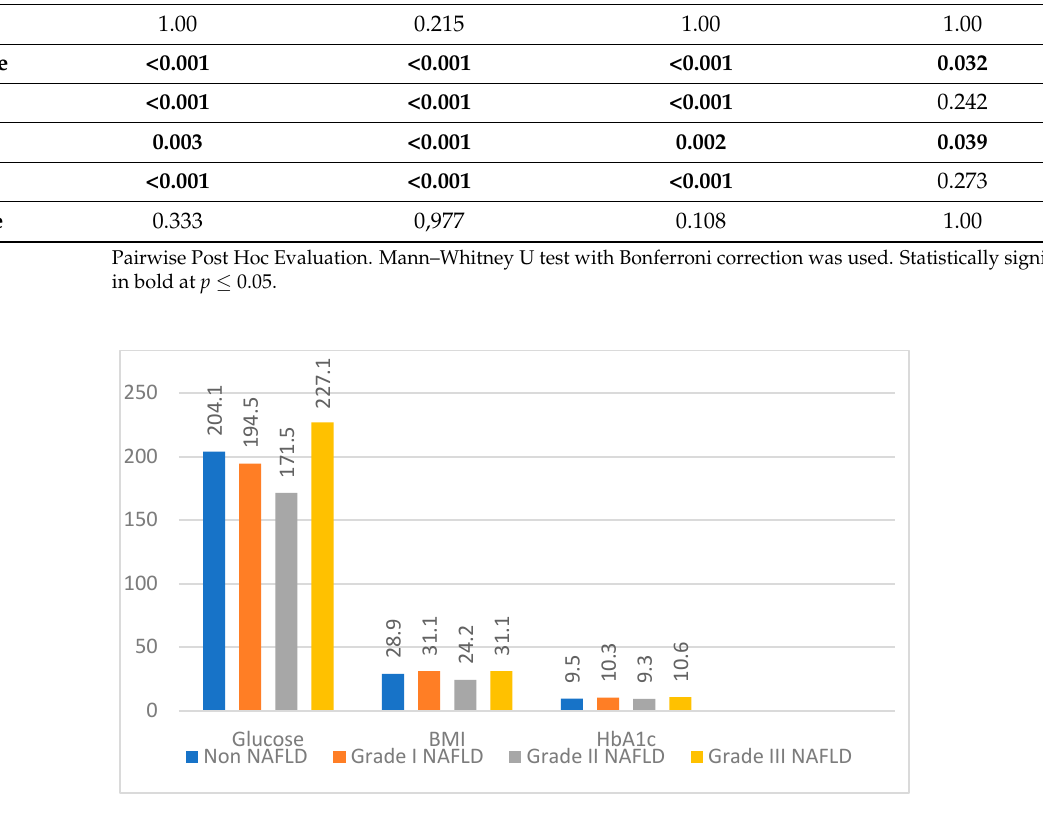
Figure 2. Fasting glucose (n = mg/dL), BMI (n = n) and HbA1c (n = %) measurements according to